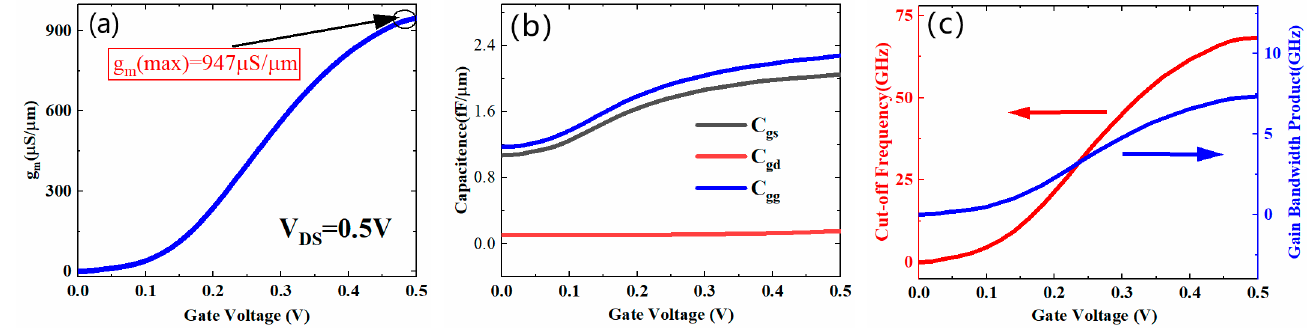
Figure 12. ( a ) Transconductance curves, ( b ) parasitic capacitance curves, and ( c ) f T and GBP curves of the HJTFET.